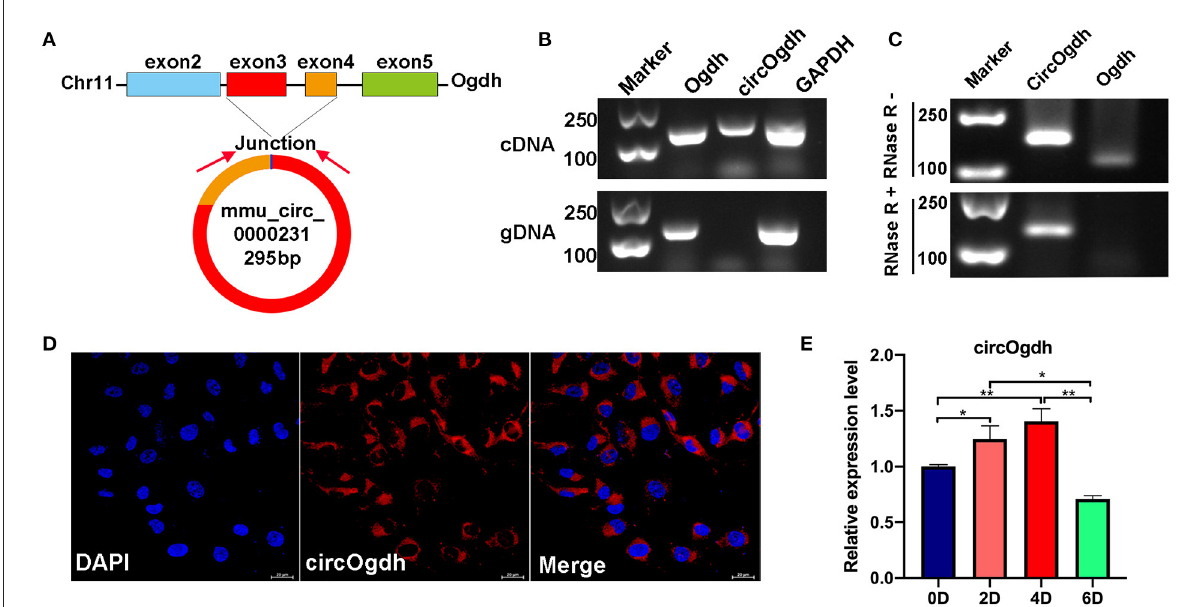
FIGURE6 Expression and biological functions of circOgdh. (A) Genomic locus of circOgdh gene. circOgdh is produced at the Ogdh gene (NM_001252282.1) locus containing exons 3-4. (B) PCR analysis for circOgdh and its linear isoform Ogdh in cDNA and genomic DNA (gDNA). (C) The RNase tolerance of circOgdh was verified through RNase R treatment and RT-qPCR. (D) Cellular localization of circOgdh was detected via FISH. Nuclei were labeled with DAPI dye. The majority of circOgdh was labeled with Cy3 (Red). Scale bar, 20 µ m. (E) RT-qPCR was used to detect the expression of CircOgdh during mouse brown adipocytes differentiation. The values are means ± SEM ( n = 3), * P < 0.05, ** P <